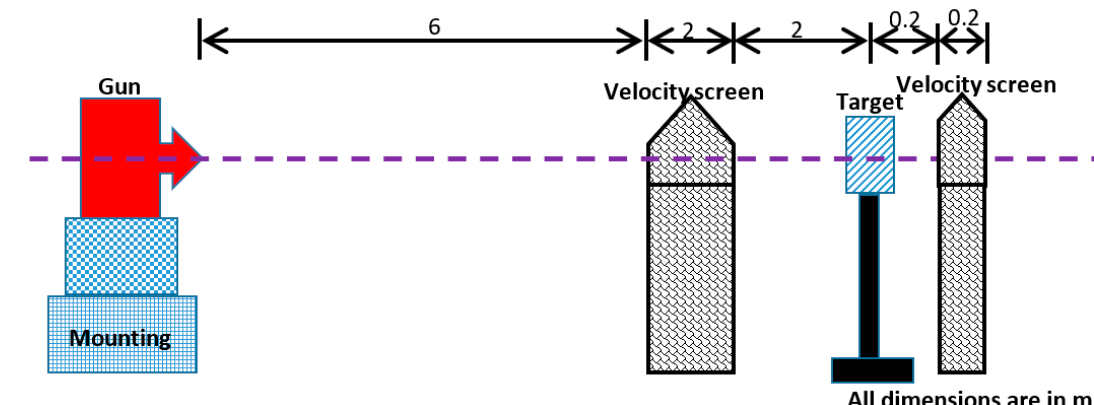
Figure 1. Schematic diagram of bullet penetration test.